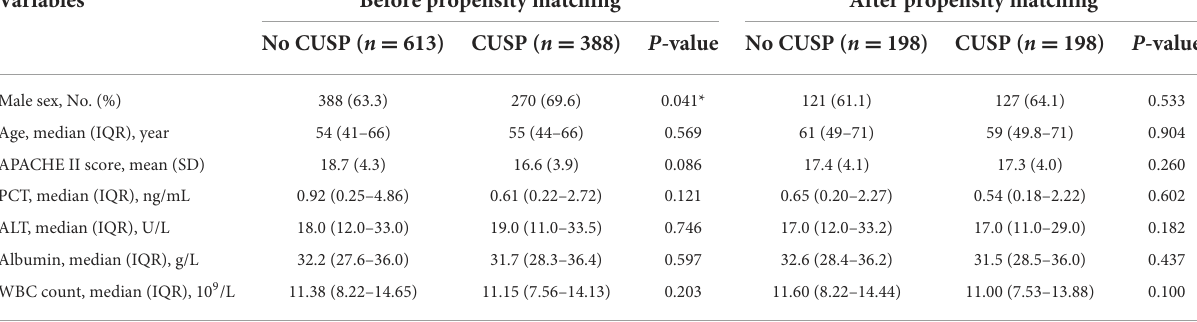
TABLE 2 Baseline characteristics of no CUSP group and CUSP group in the SICU setting.